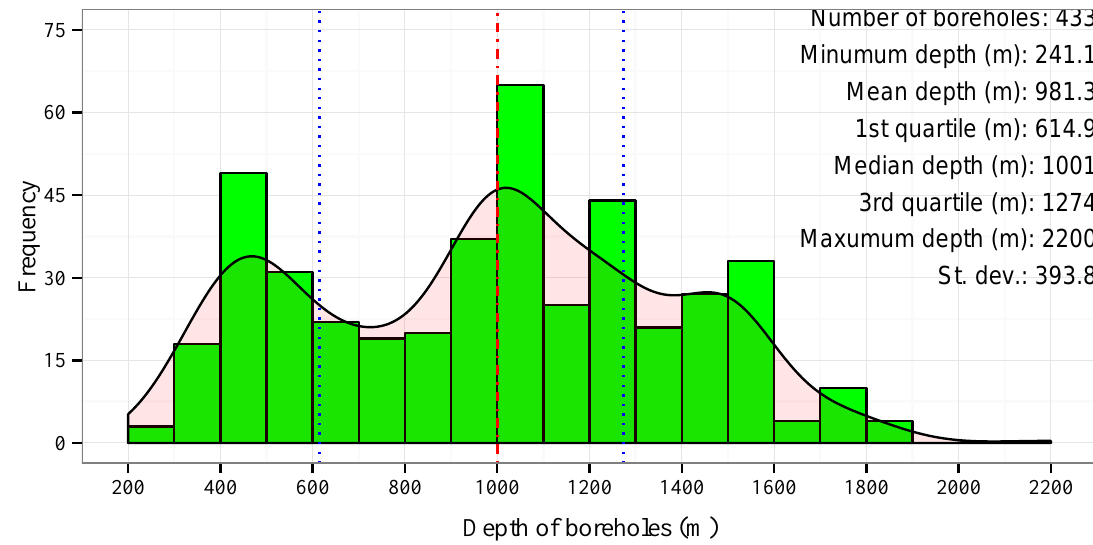
Figure 3. Histogram of borehole depths. The dashed red and blue lines and curve denote median, 1st and 3rd quartile depth and density, respectively.